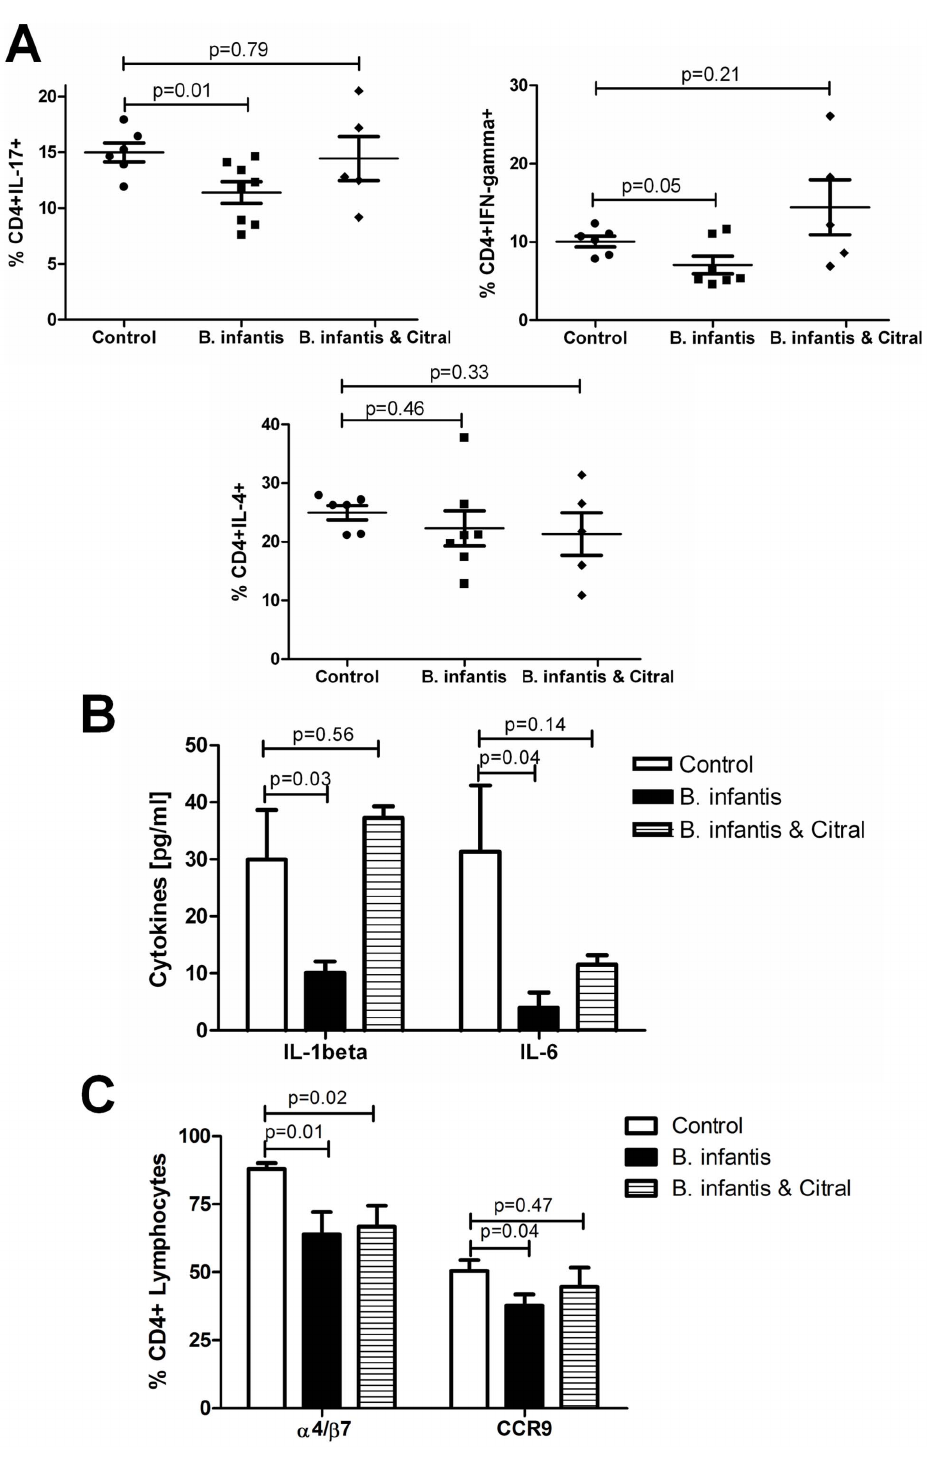
Figure 3. B.infantis alters lymphocyte phenotypes within the LP. ( a ) IL-17 + lymphocytes were significantly reduced and IFN-gamma + cells were substantially reduced within the LP of B. infantis -fed mice (n=8), compared to the control group (n=6), an effect that was blocked by citral (n=5). No effect was observed for IL-4 + lymphocytes. ( b ) Isolated LP was cultured in vitro and cytokine secretion measured after 24 hours. B. infantis feeding reduced the in vitro secretion of the T H 17-polarising cytokines IL-1 b and IL-6, which was partially reversed by citral. ( c ) B. infantis feeding was associated with a decrease in the proportion of LP lymphocytes expressing the gut homing receptors a 4 b 7 and CCR9. Citral did not reverse the decrease in a 4 b 7 + lymphocytes and had a minor influence on CCR9 + lymphocytes. Statisical significance was estimated using unpaired student t- tests.